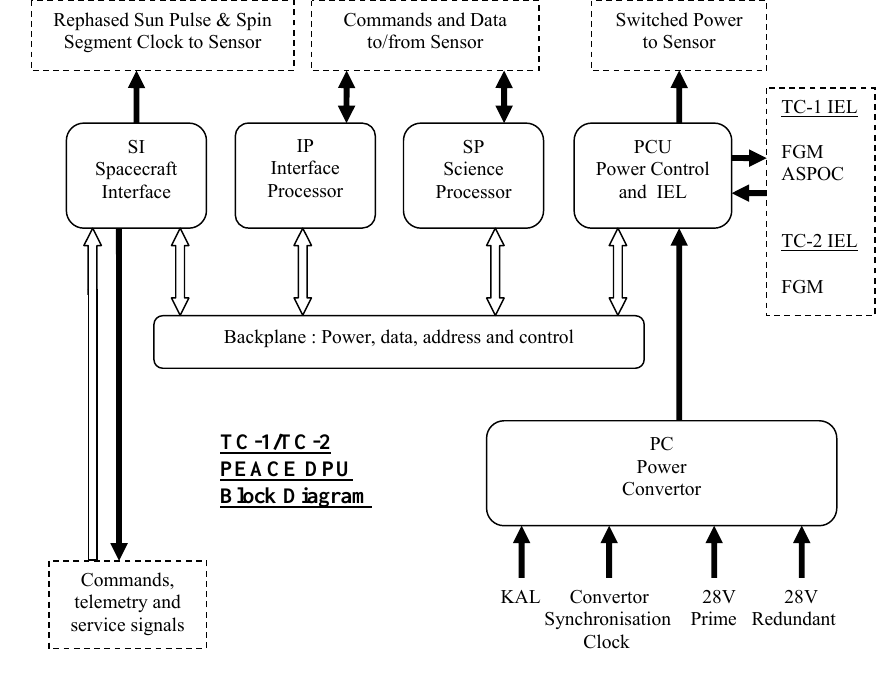
Figure 7. Block Diagram of PEACE DPU Fig. 7. Block diagram of PEACE